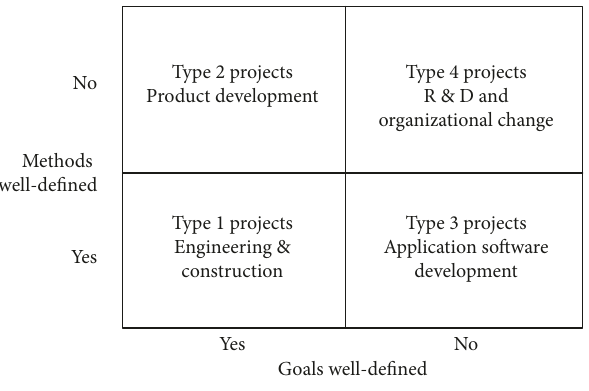
Figure 1: Goals and methods matrix